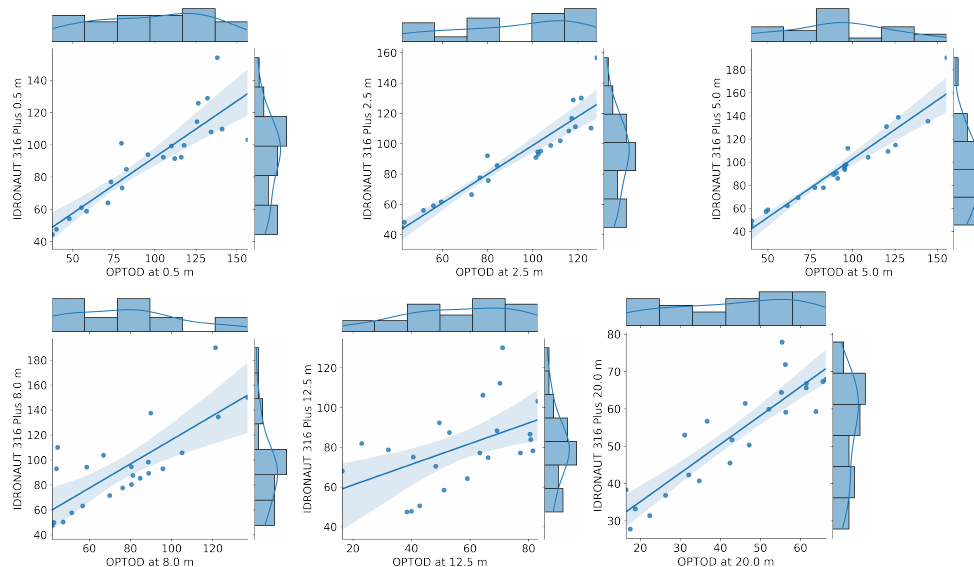
Figure 18. Point to point comparison of dissolved oxygen saturation time-series between AHFM and manual sampling with an IDRONAUT 316 Plus probe.